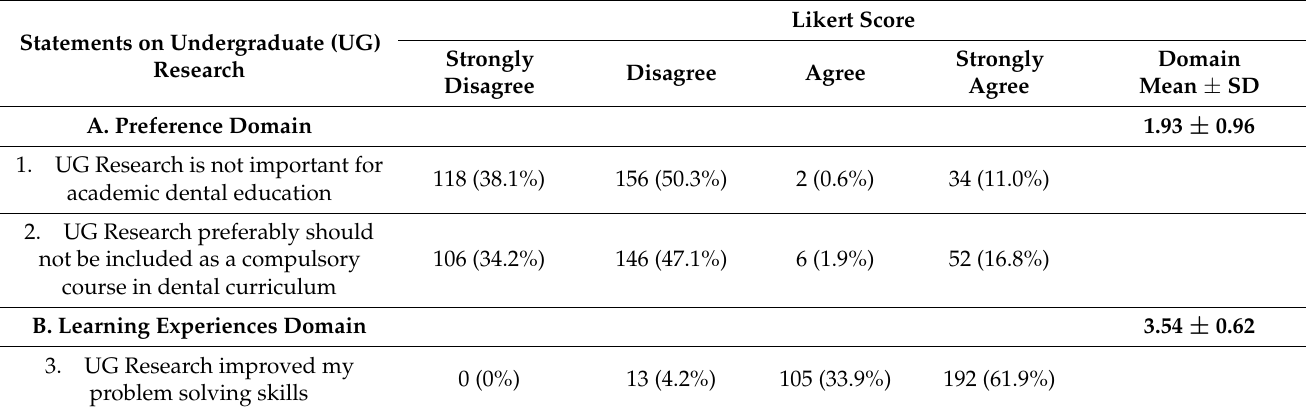
Table 3. Perception of UG Research